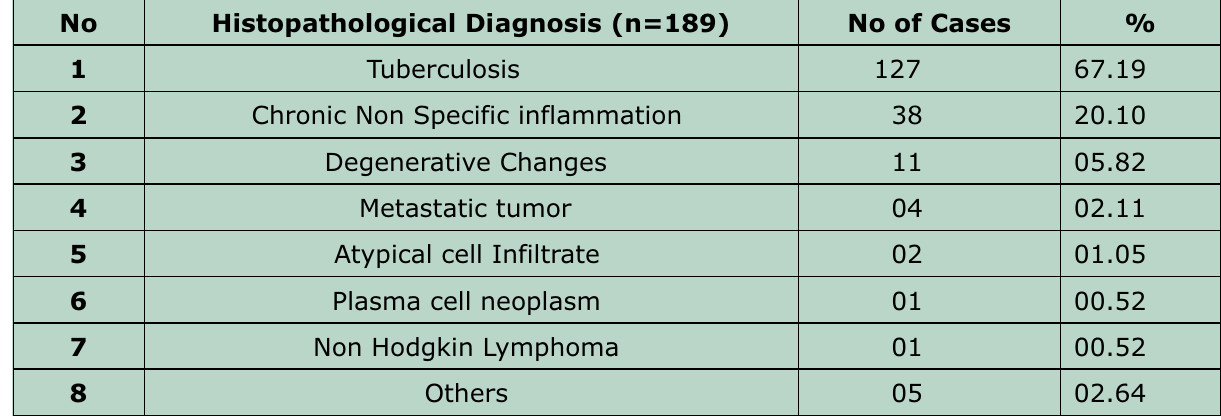
AMIN MS, BUTT S, et Table-I: Histopathological diagnoses in spine biopsies clinically suspected as tuberculosis. No